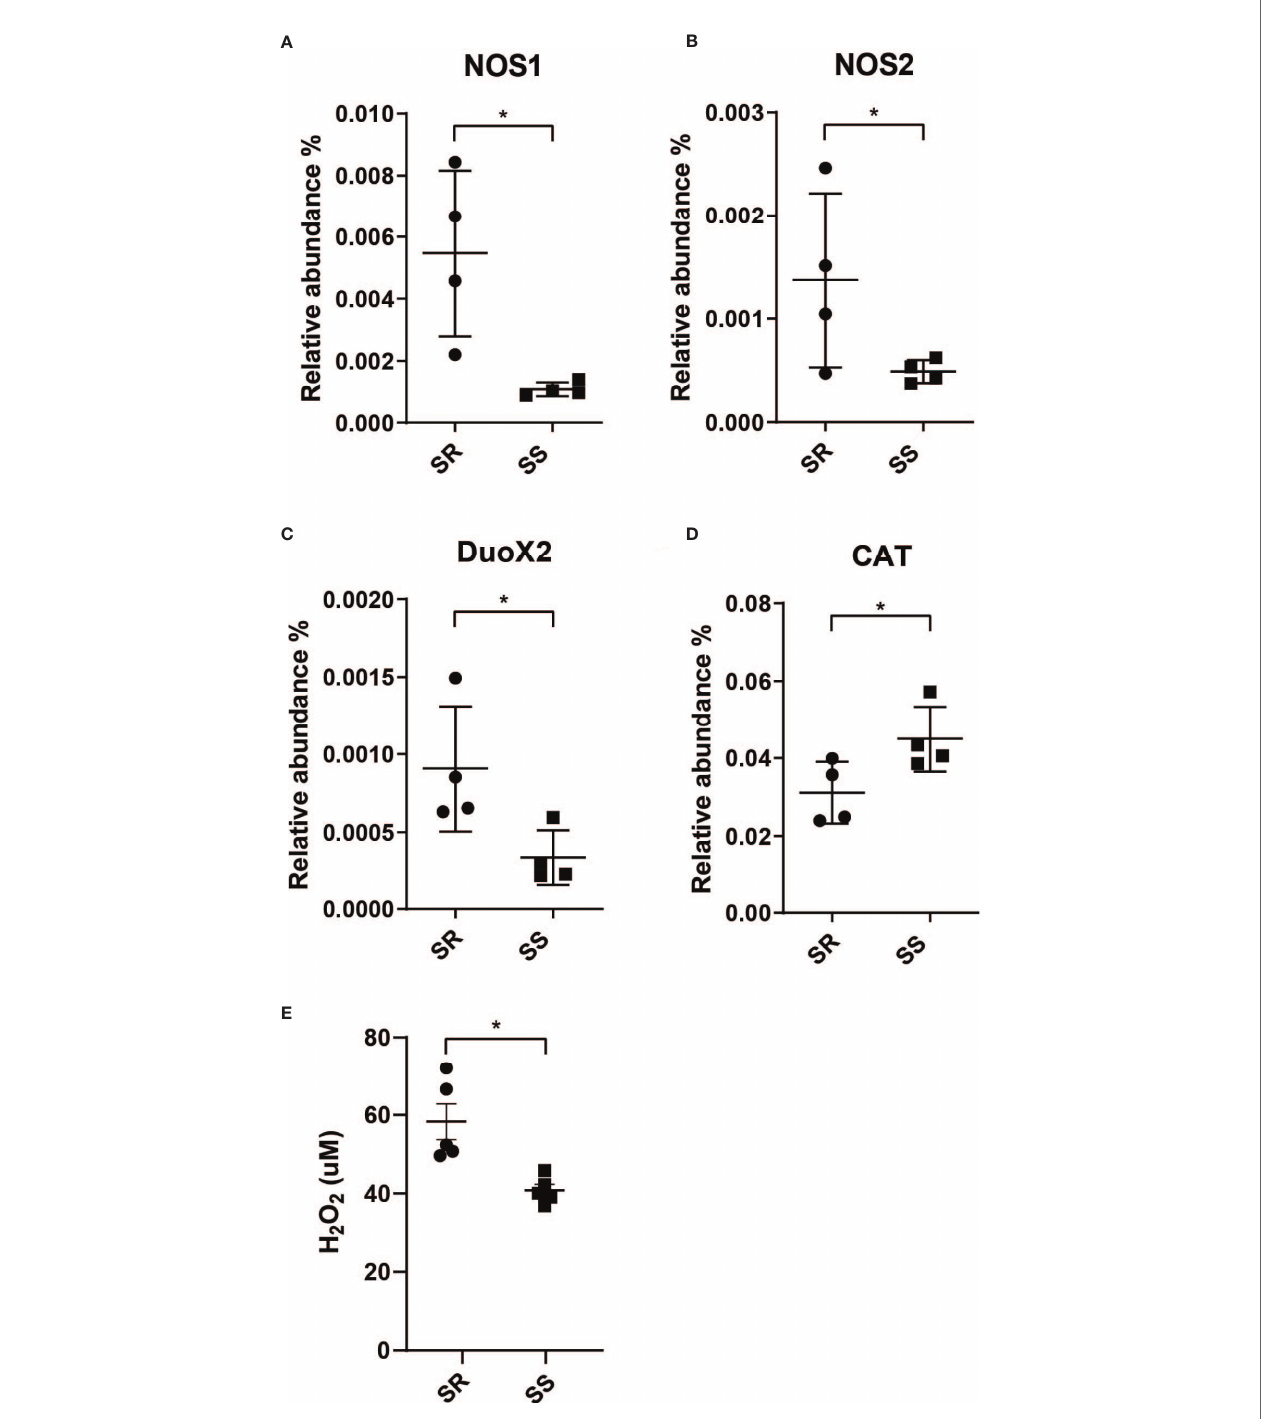
FIGURE 3 | Community-dependent host oxidative stress responses during V. cholerae expression. Host genes involved in the synthesis of reactive nitrogen species. (A) Nitric oxide synthase 1 (NOS1). (B) Nitric oxide synthase 2 (NOS2) and reactive oxygen species. (C) Dual oxidase 2 (DUOX2). (D) Catalase (CAT). (E) H 2 O 2 level measured from collected intestinal homogenates (n = 4, *P <